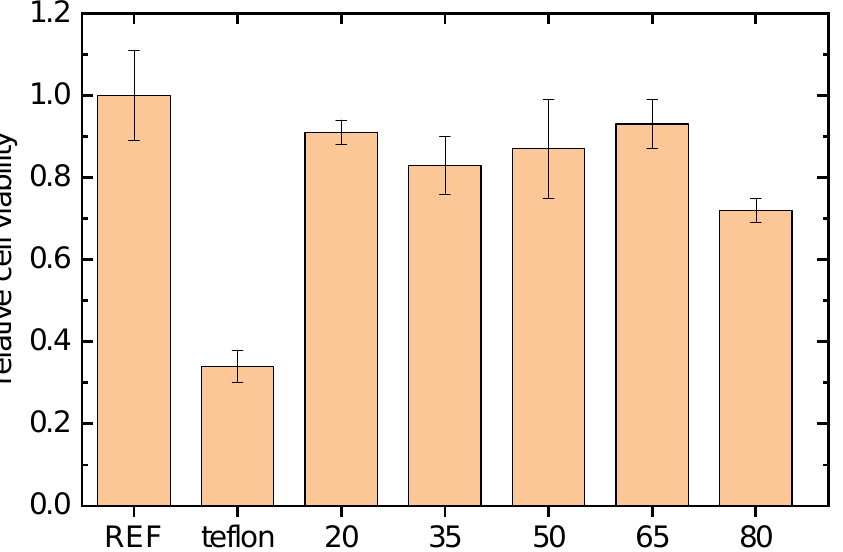
Figure 3. In vitro cytocompatibility results of tested PB films deposited at different flow rates of the monomer. REF marks tissue polystyrene, teflon marks bare substrate and the numbers are monomer flow rates in